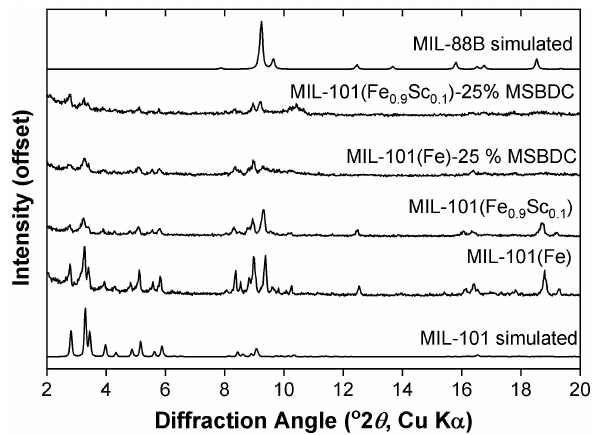
Figure 3. Powder X-ray di ff raction patterns of samples of MIL-101 prepared by solvothermal synthesis at 3 hour reaction times. The simulated pattern of MIL-101 was produced from the published structure of F é rey et al. [36] and that of MIL-88B from the refined di ff raction profile in this work for